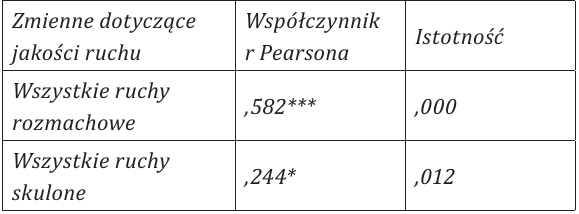
Jak widzimy na podstawie danych widocznych w Tabeli 7., wszystkie wypowiedzi mówiące o ruchach skulonych w formie postawy, ruchach złożonych ujęte w Tabeli 6. mówią, że wszystkie ruchy rozmachowe i wszystkie ruchy skulone współwystępowały z wypowiedziami „światłocieniowymi”. W Tabeli 7. podane są kolejne związki poszczególnych jakości ruchów a wypowiedziami